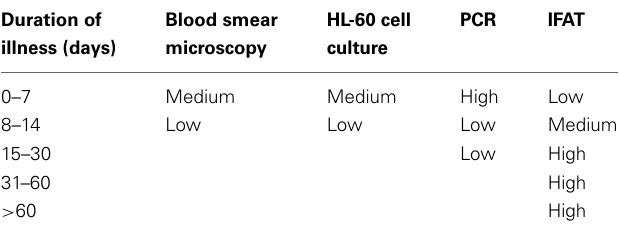
Table 2 | Relative sensitivity of diagnostic tests for A. phagocytophilum infection in humans (modified after Bakken and Dumler,